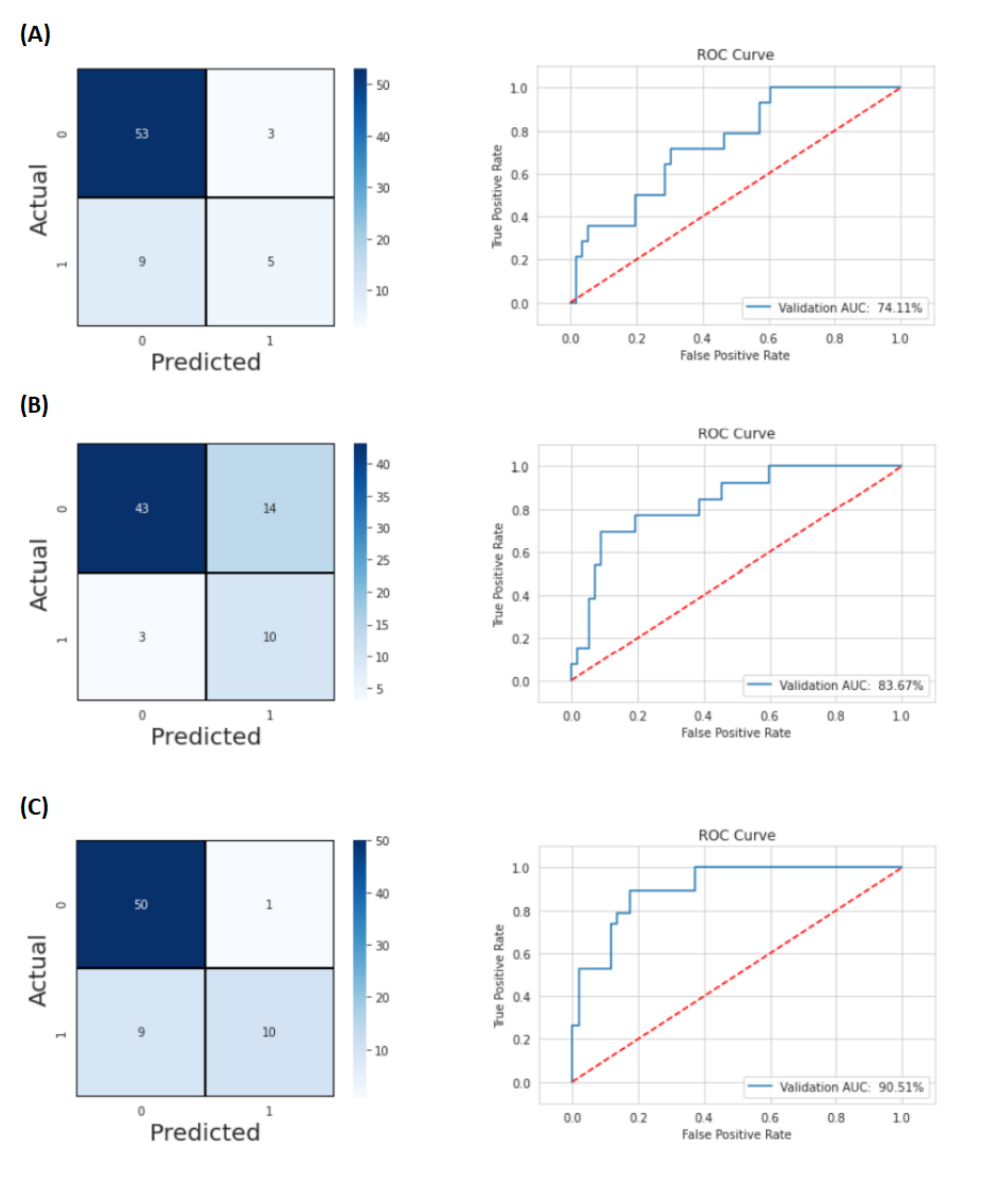
Figure 5. Confusion matrices and ROC curves of the project using imaging features, clinical variables, and the time information—Experiment 2. ( A ) For LR prediction, the AUC is 0.7411; ( B ) the AUC for DM prediction is 0.8367; ( C ) the AUC for OS prediction is